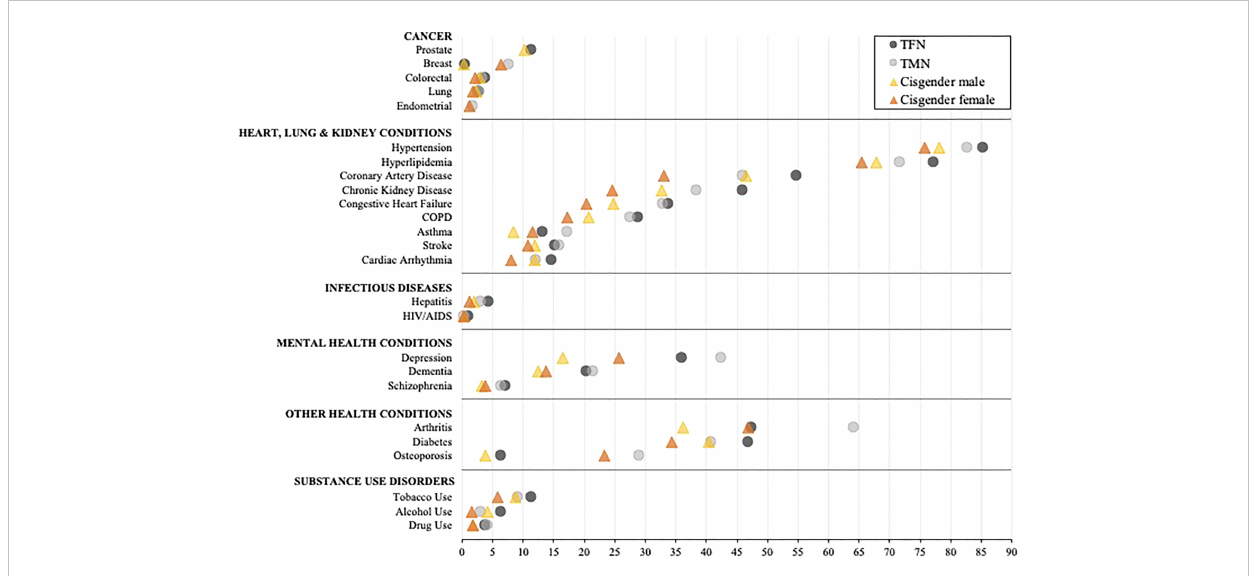
FIGURE 1 Comparison of the adjusted predicted probabilities of health condition diagnosed strati fi ed by inferred gender among age-entitled transgender and cisgender Medicare bene fi ciaries, 2008-2017. TFN, Trans Feminine and Nonbinary; TMN, Trans Masculine and Nonbinary. COPD, Chronic obstructive pulmonary disease. The symbols represent the adjusted predicted probabilities when age, enrollment length, race/ethnicity, and census region are set to their means. The 95% con fi dence intervals are shown in Table 2. Within each diagnostic category, the conditions are represented from high to low based on the probability of each diagnosis for TFN